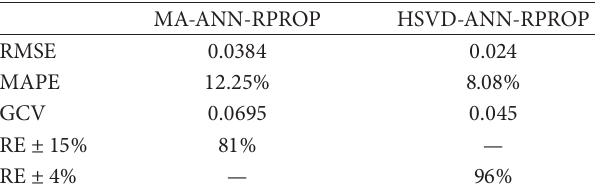
Table 3: Forecasting with